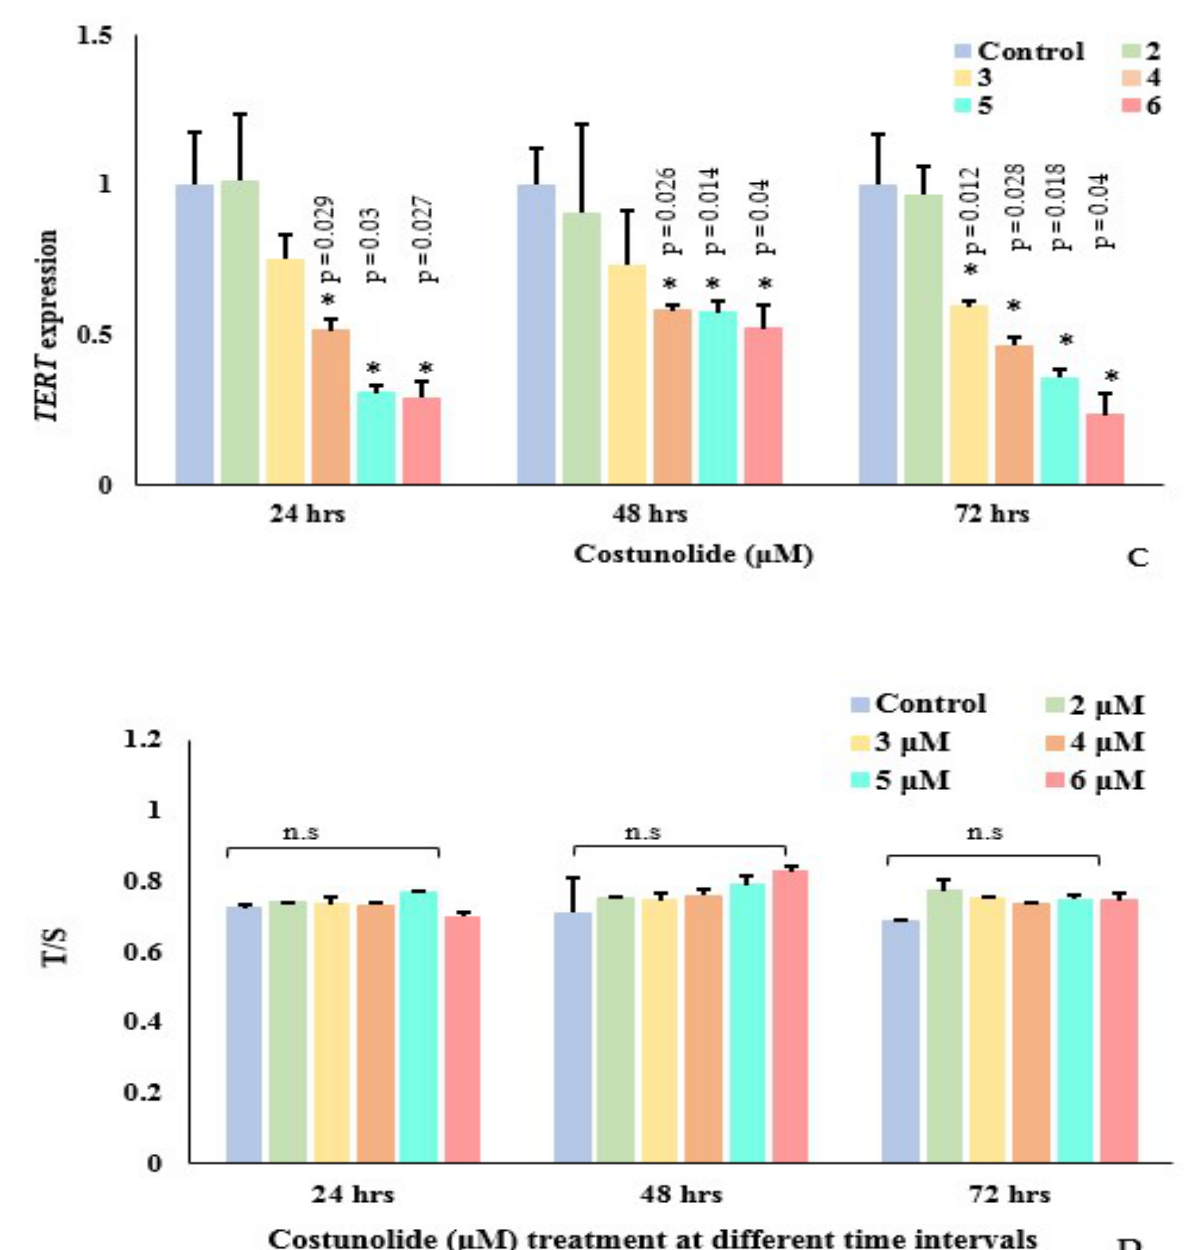
Figure 4. Effect of costunolide on EpCAM , Myc , TERT genes, and telomere length. ( A – C ) Effect of costunolide on EpCAM , Myc, and TERT mRNA expression in Jurkat cells at 24, 48, and 72 h. ( D ) Telomere length in costunolide-treated (2–6 µ M) and untreated Jurkat cells at three different time points (24, 48, and 72 h). n.s indicates non-significant p value > 0.05. *, **, *** indicates p values < 0.05, < 0.01 and < 0.001 (one-way ANOVA). Error bars represents standard error of mean. T/S indicates relative telomere length.